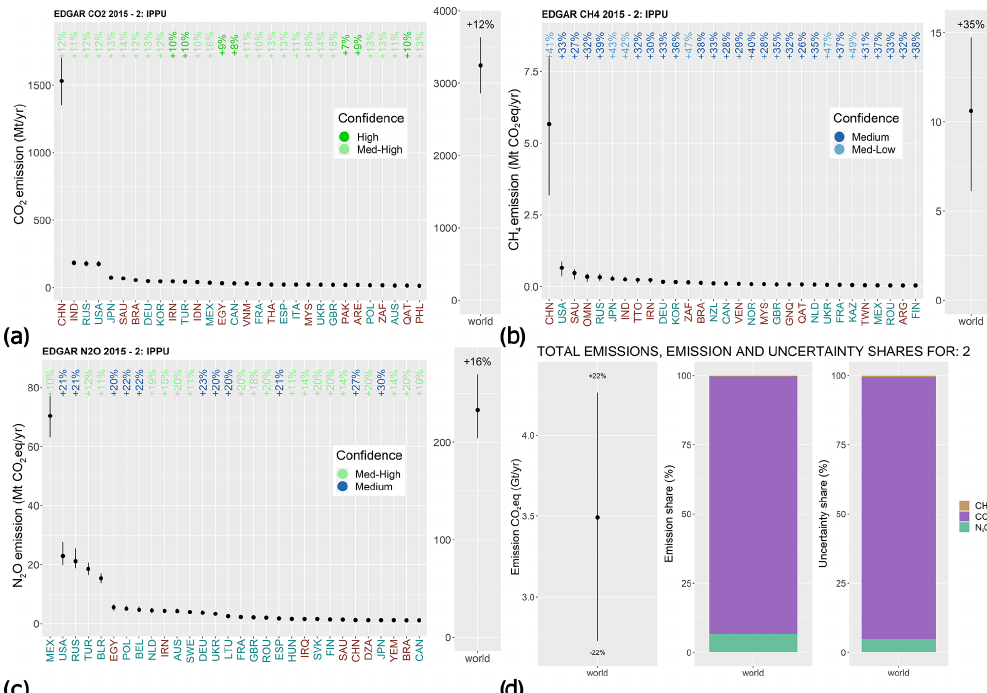
Figure 6. GHG emissions from the top emitters and the world for sector 2 (industrial processes and product use): (a) CO 2 ; (b) CH 4 ; (c) N 2 O; (d) the world total emission uncertainty and the world emission and uncertainty shares. The country names are colour-coded according to their classification (cyan denotes industrialized, and red denotes developing). Confidence levels are given in the following ranges: high (0%, 10%]; medium-high (10%, 20%]; medium (20%, 40%]; medium-low (40%, 60%]; low (60%, 100%]; and very low > 100%. (Country codes are given in Table